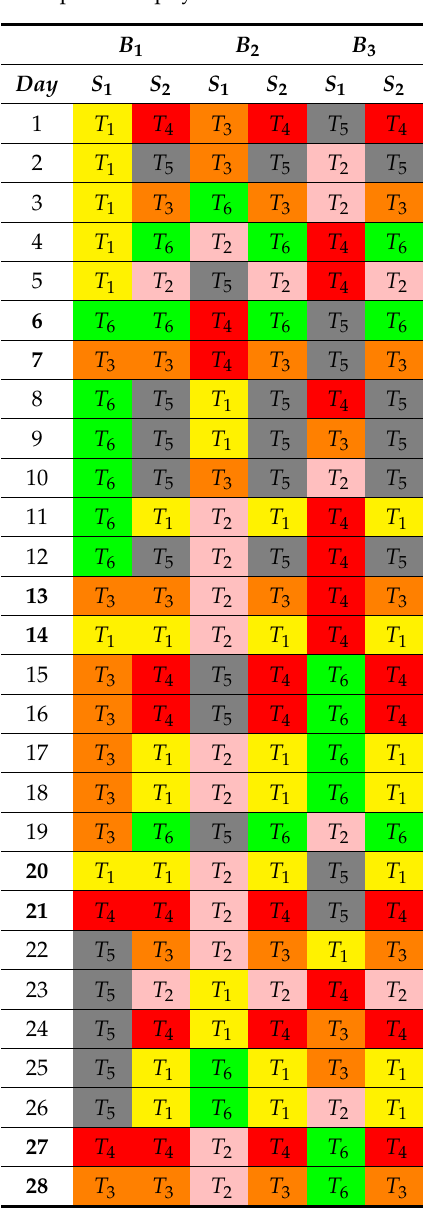
Table 4. Optimized physician schedule for